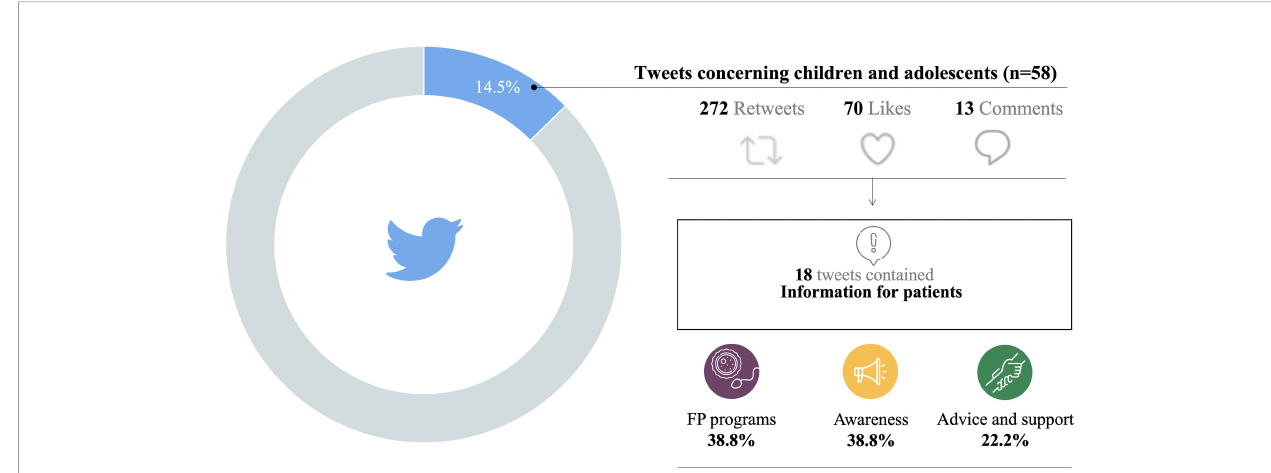
FIGURE 4 | OF and FP information shared on Twitter regarding children and